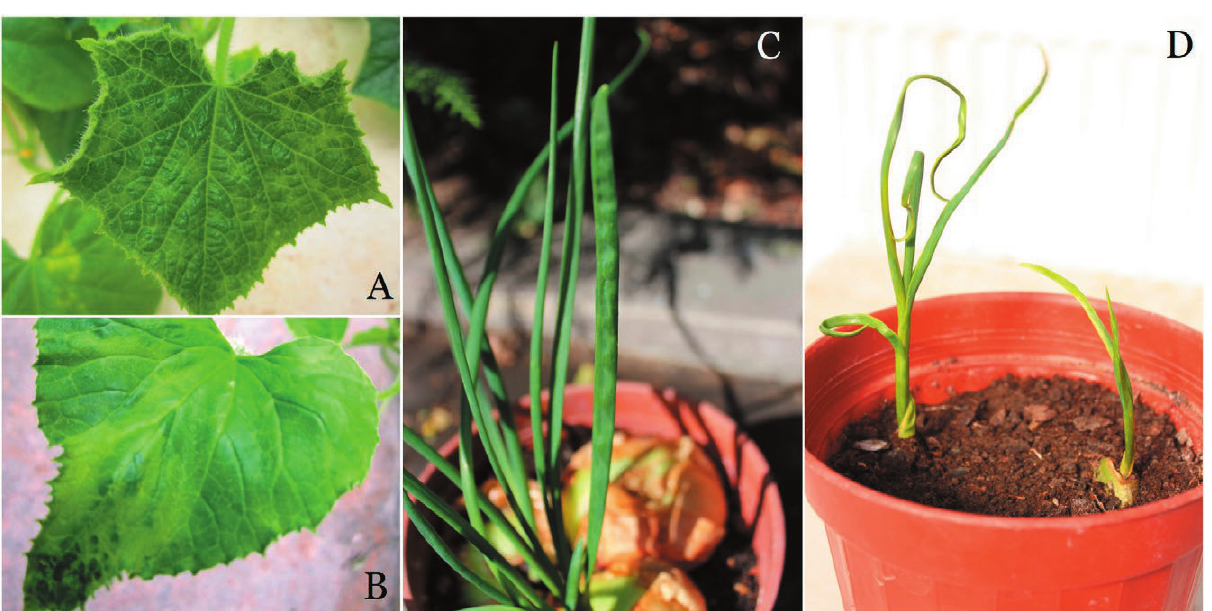
Table 2. Symptoms caused from inoculations with two CMV isolates on different inoculated test plants. Isolate Plant species